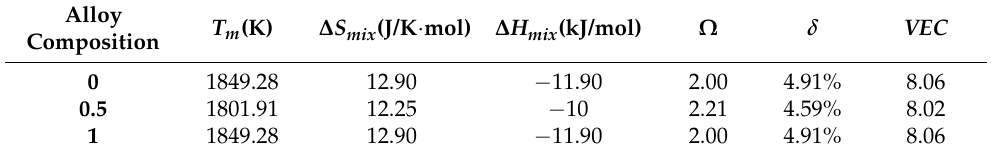
Table 3. Results of Tm, Δ S mix , Δ H mix , Ω , δ and VEC of Al x Ti 1− x ( x = 0, 0.5, 1) HEAs’ coatings. Alloy Composition